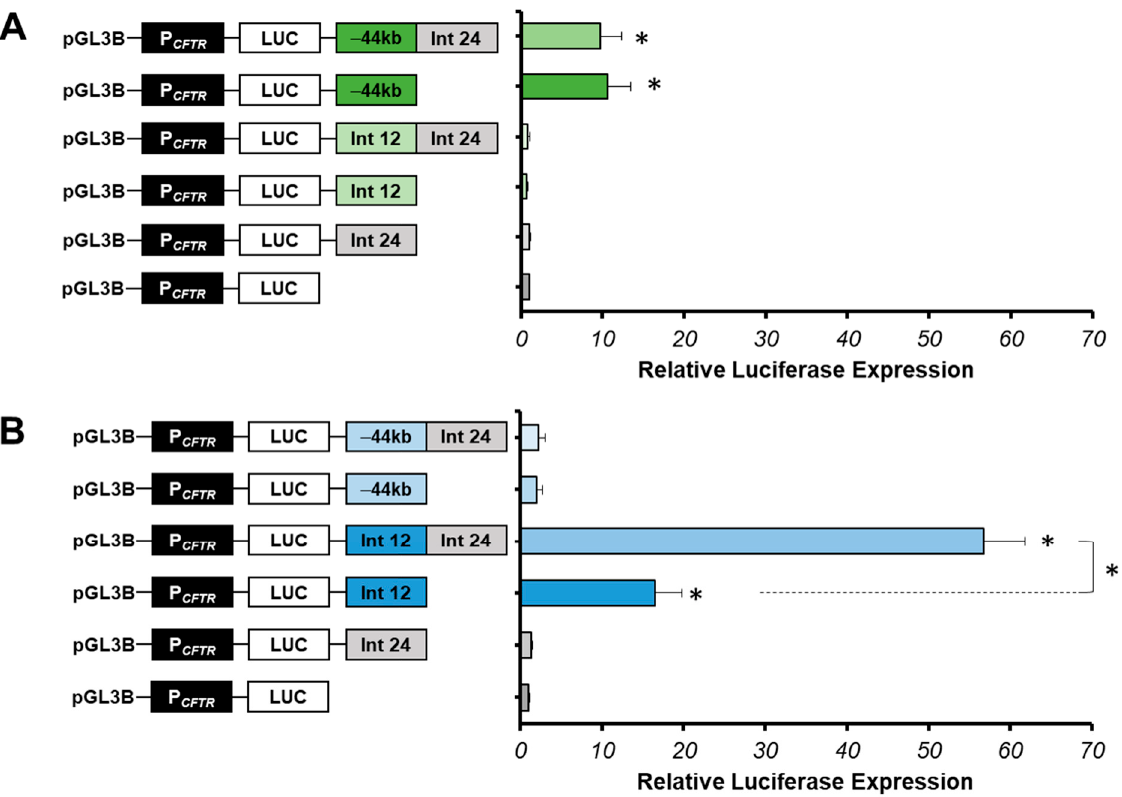
Figure 3. Cell-type specificity of the intron 24 cCRE. ( A ) Luciferase reporter constructs with the CFTR promoter (P CFTR ; 787 bp) and cis -regulatory elements combined or alone (Intron 24:Int24; Intron 12:Int12; − 44 kb) were transfected in pulmonary 16HBE14o-cells. Intron 12 enhancer is a positive control. ( B ) Luciferase reporter constructs with the CFTR promoter (P CFTR ; 787 bp) and cis -regulatory elements combined or alone (Int24; Int12; − 44 kb) were transfected in intestinal Caco-2 cells. Enhancer at − 44 kb of the CFTR gene is a positive control in pulmonary 16HBE14o- cells, and a negative control in intestinal Caco-2 cells. Luciferase expression values are reported at β -galactosidase expression values (control of transfections). Error bars represent the standard error of the mean (SEM; n = 9), * p < 0.002, using unpaired t -tests.